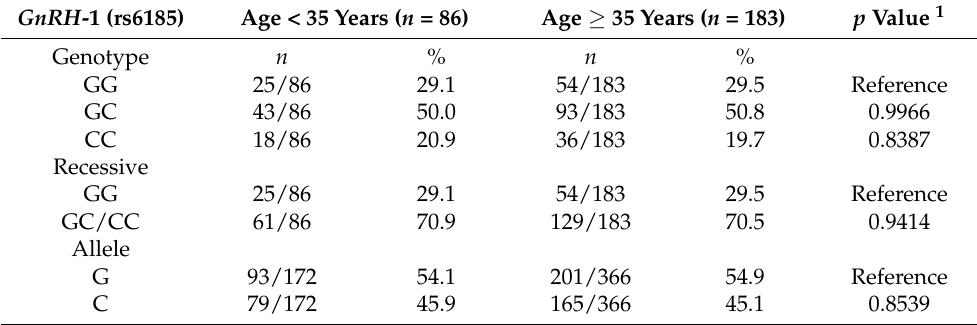
Table 4. The frequencies of GnRH -1 (rs6185) SNP among women with serum AMH < 1.2 ng/mL in varied age groups.